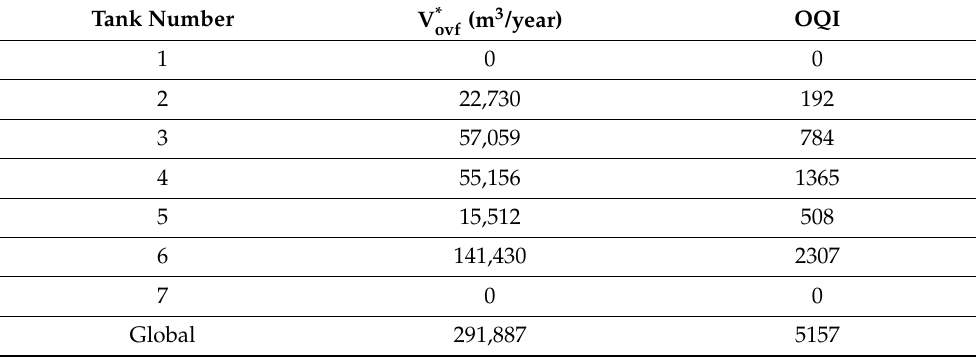
Figure 11. Best and average fitness evolution in control strategy #2 when minimizing V ovf . Table 9. Simulation results when the volume of overflow is minimized (strategy